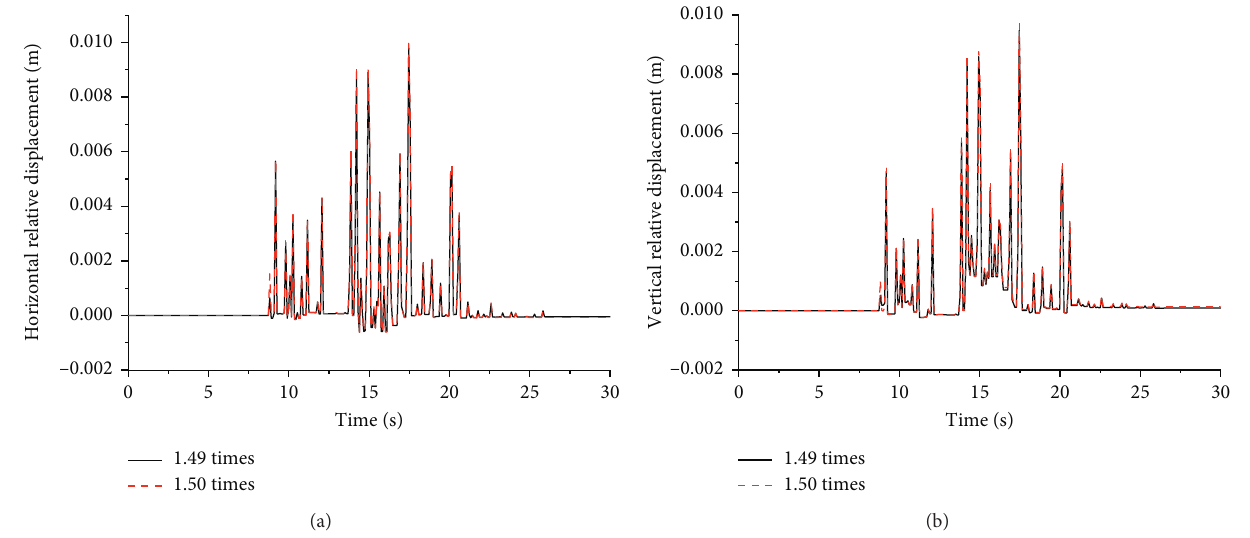
Figure 21: Time histories of displacement difference of joint pairs of 16. (a) Horizontal. (b) Vertical.